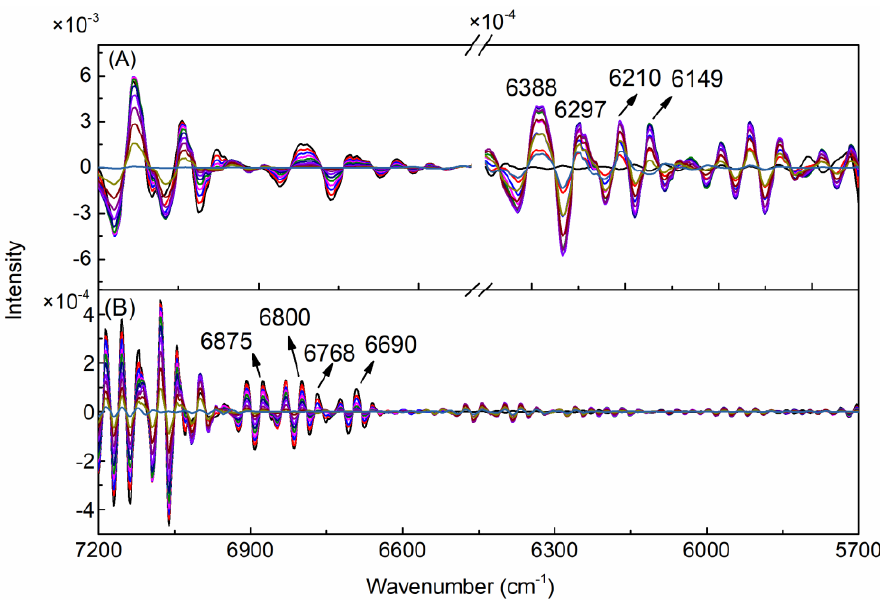
Figure 6. High-resolution information in the NIR spectrum of H 2 O − D 2 O obtained by WPT.